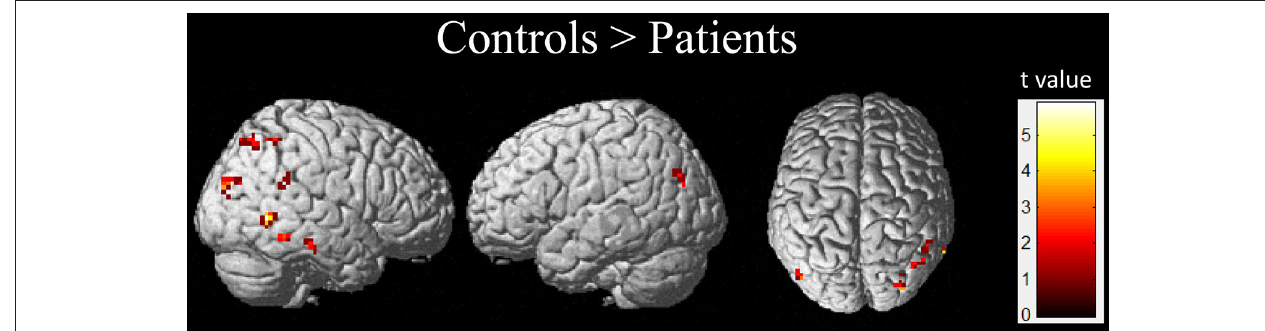
FIGURE 3 | The regions showed the significant decrease of fALFF in the children with GTCS.